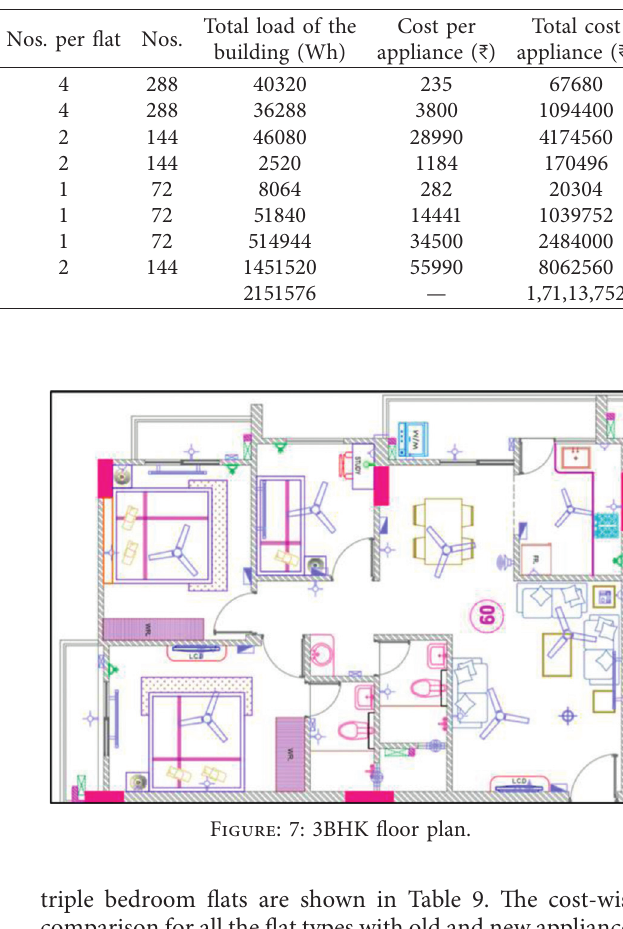
Table 4: Load calculation—improved appliances—2BHK.